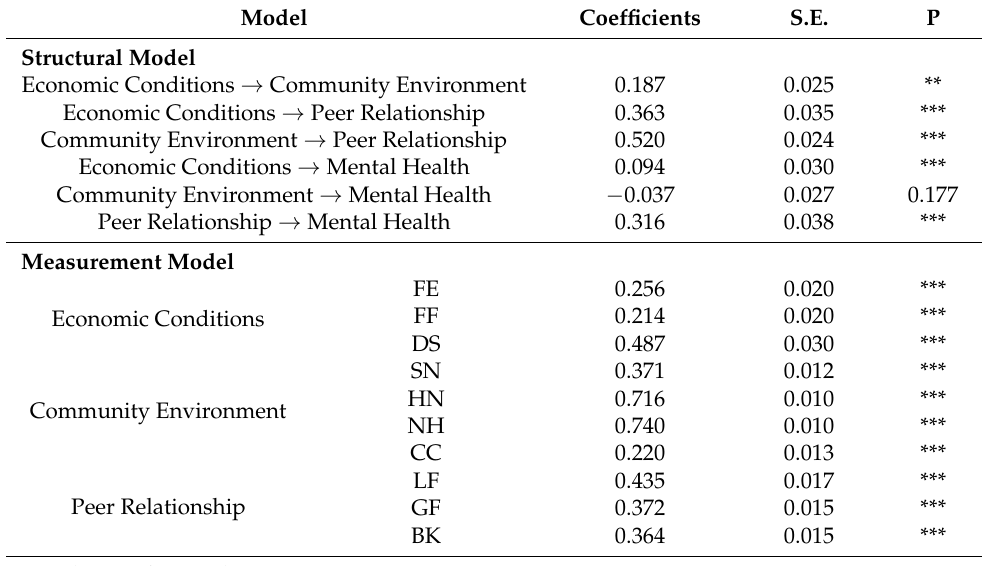
Table 2. Model maximum likelihood estimation results.